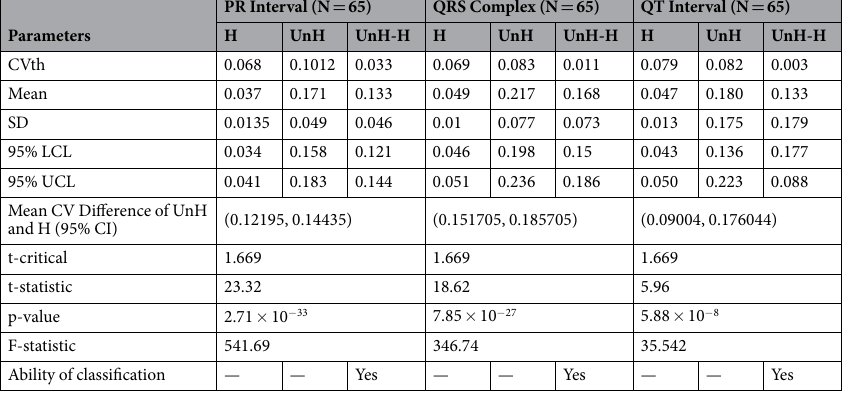
Table 1. Performance results of proposed methodology on localized features. * Healthy = H, Unhealthy =